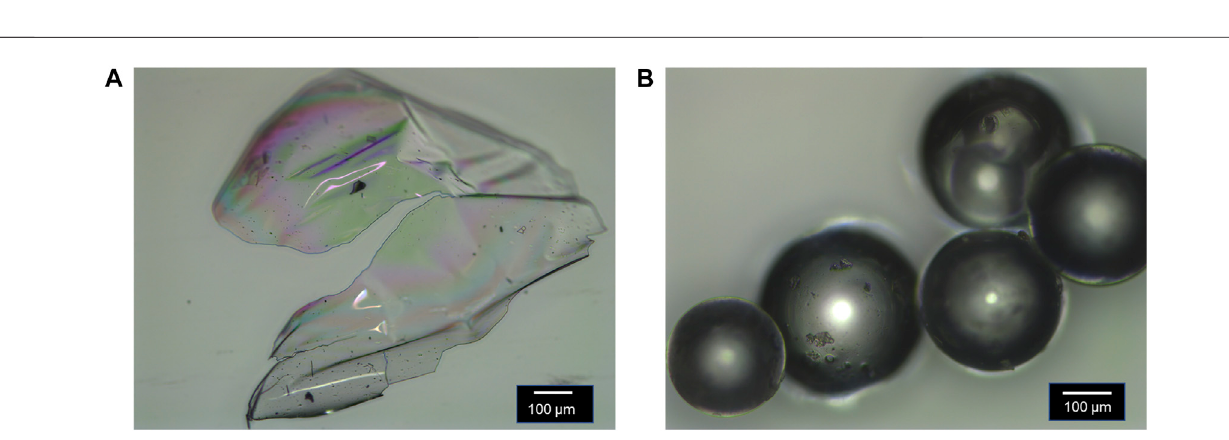
FIGURE 3 | Morphology of: (A) linear polymer P(4VP 1 -co-BMA 1 ) and (B) crosslinked polymer P(4VP 1 -EGDMA 1.0 -BMA) . Both images were collected after the polymer was dried under vacuum with heat.